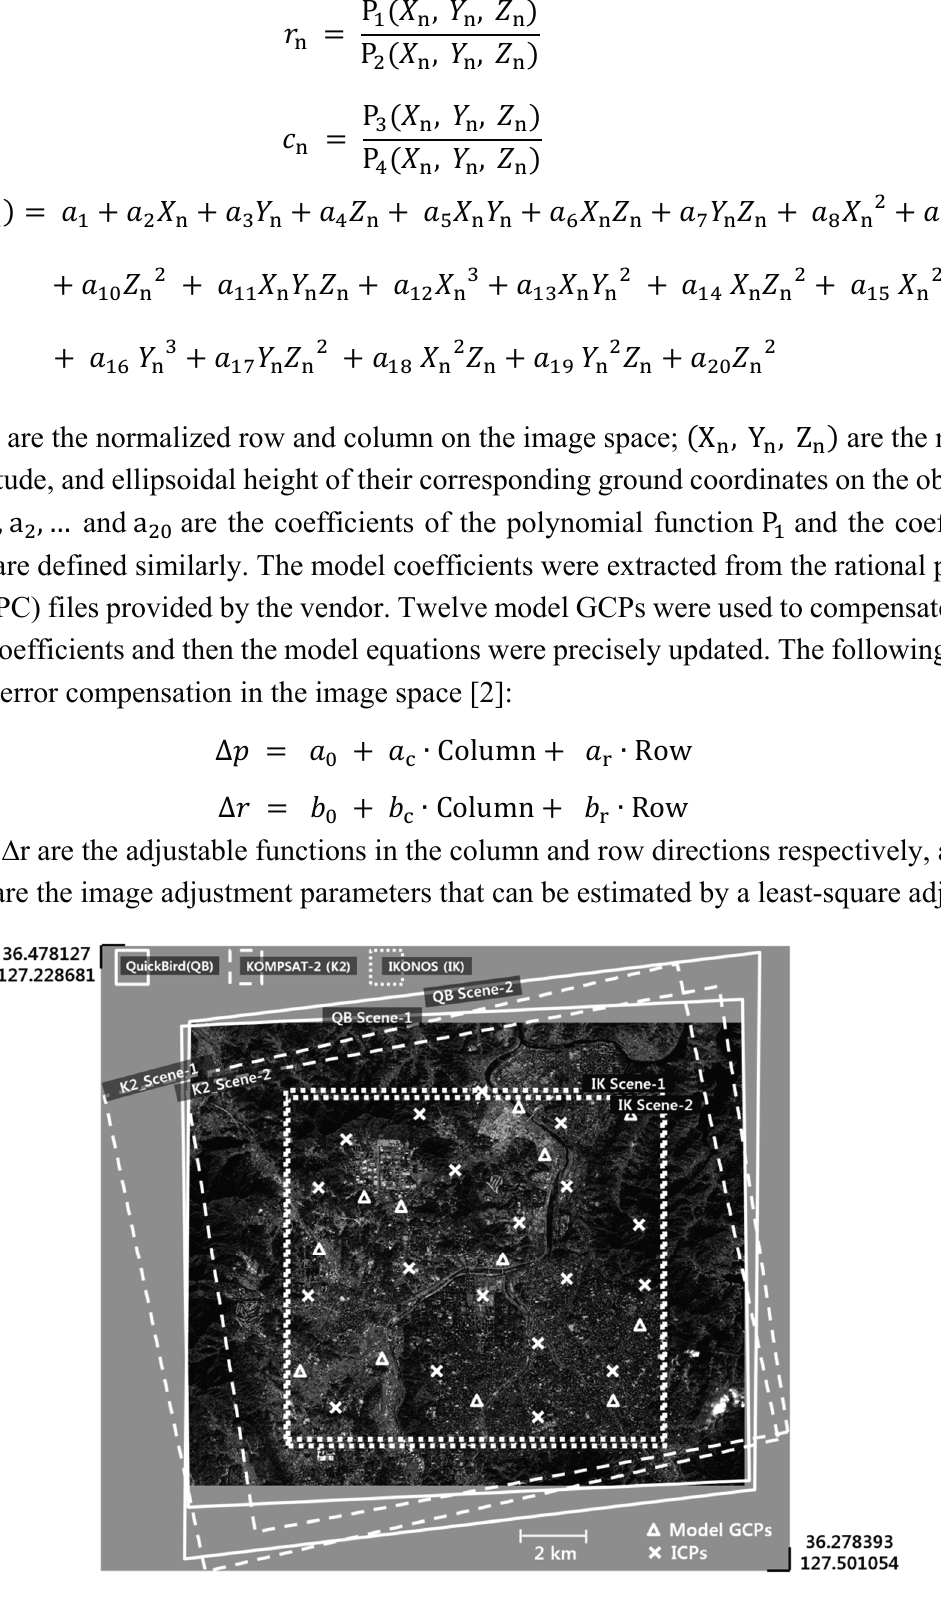
Figure 2. Image coverage and GCPs’